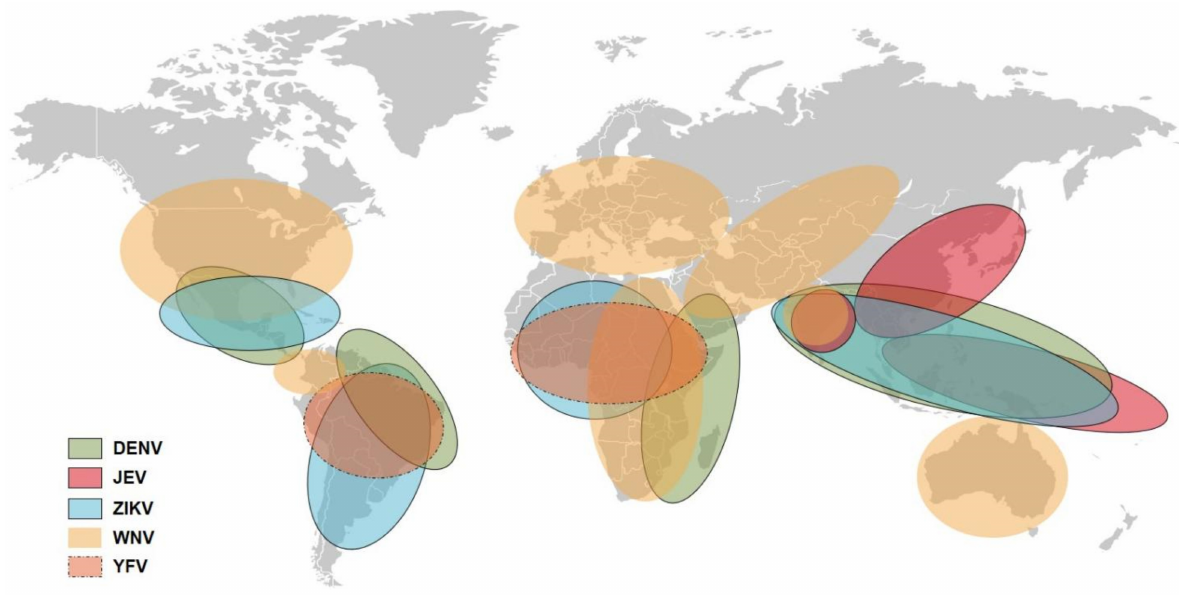
Figure 1. Global distribution of five mosquito-borne flaviviruses. The figure was created based on the epidemiological data of the WHO and the American CDC (Centers for Disease Control and